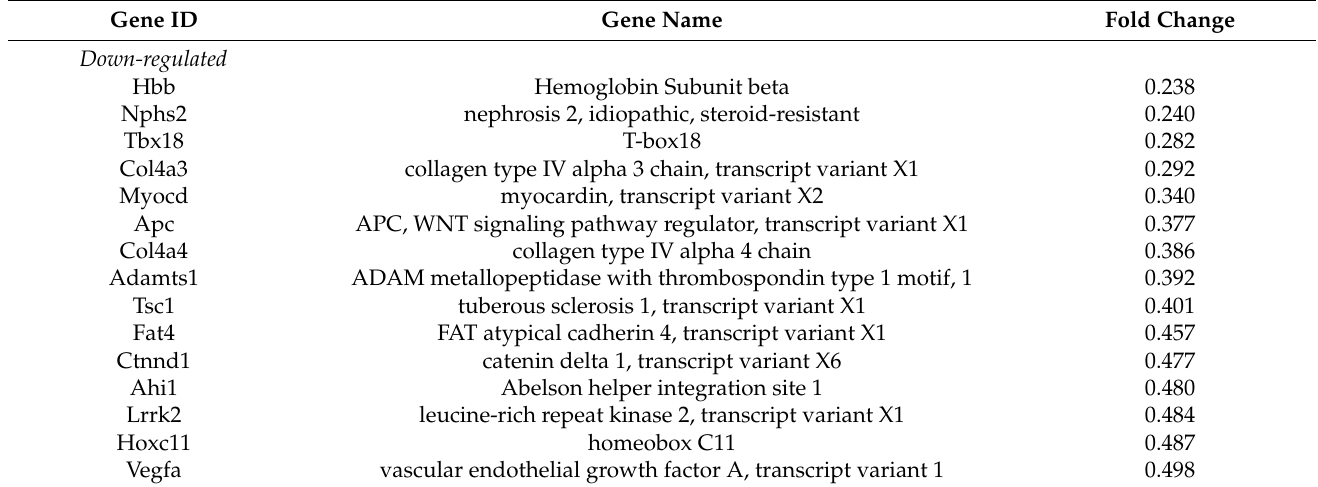
Figure 7. Differentially expressed genes in kidney tissues: ( A – C ) Scatter plots showing the correlation between the mRNA expression level in CON vs. NaCl, HMLS vs. NaCl, and HMHC vs. NaCl. ( D ) Heatmap hierarchical clustering with 344 differentially expressed genes related to renal function. ( E ) Heatmap hierarchical clustering with 424 differentially expressed genes related to the response to oxidative stress. CON, normal diet + distilled water; NaCl, 8% NaCl diet + distilled water; HMLS, 8% NaCl diet + high magnesium low sodium water; HMHC, 8% NaCl diet + high magnesium high calcium water. Table 2. Renal-System-Related Gene Expressions in the NaCl vs. HMLS